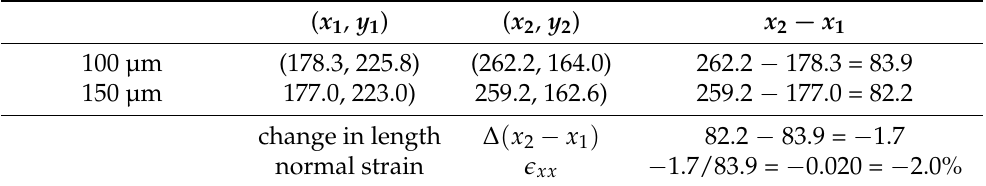
Table 2. Horizontal normal strain estimated from representative coordinates.